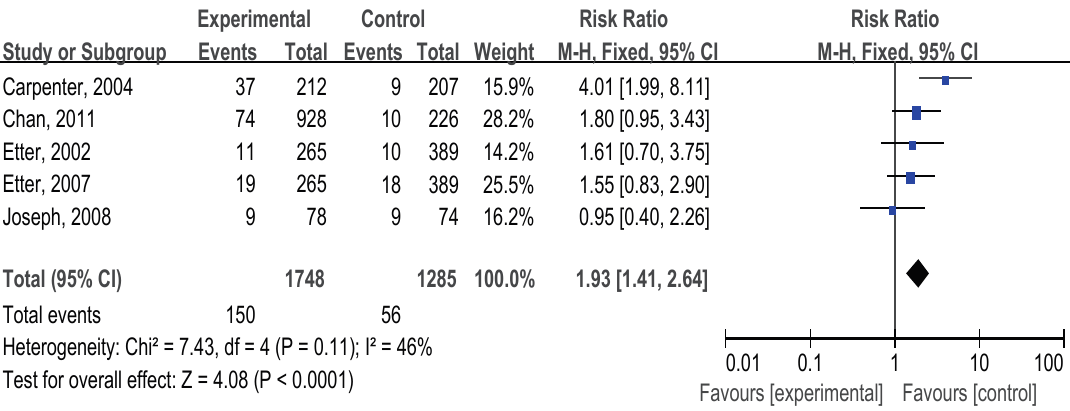
Figure 2. Forest plot of comparison: reduction support plus medication vs. reduction support plus placebo.